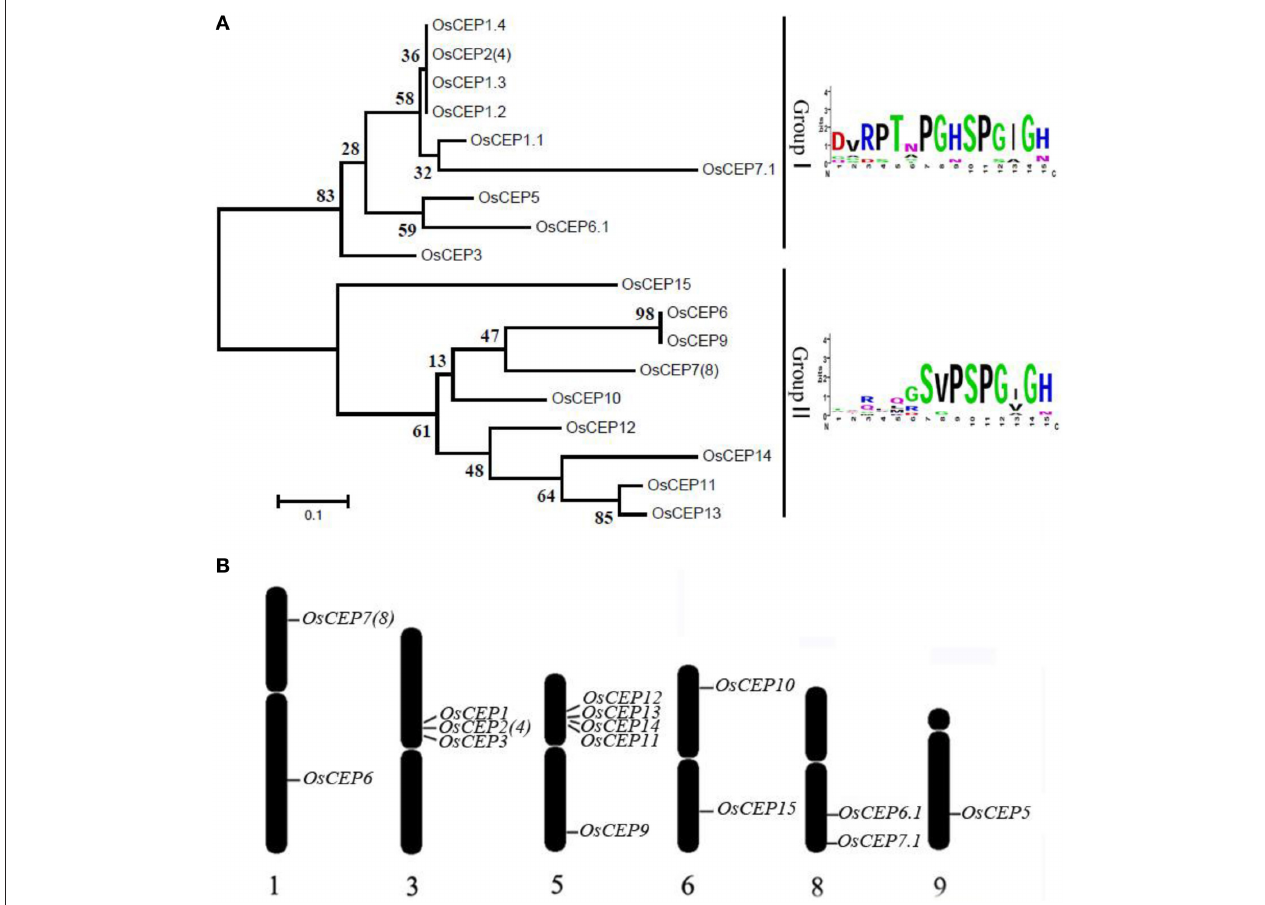
FIGURE 2 | Distribution of CEP genes found in the rice genome. (A) Phylogenetic tree and WebLogo plot were used to show rice CEP gene clustering and the 15-amino acid CEP domain conservation. (B) Chromosomal distribution of CEP genes in the rice genome.